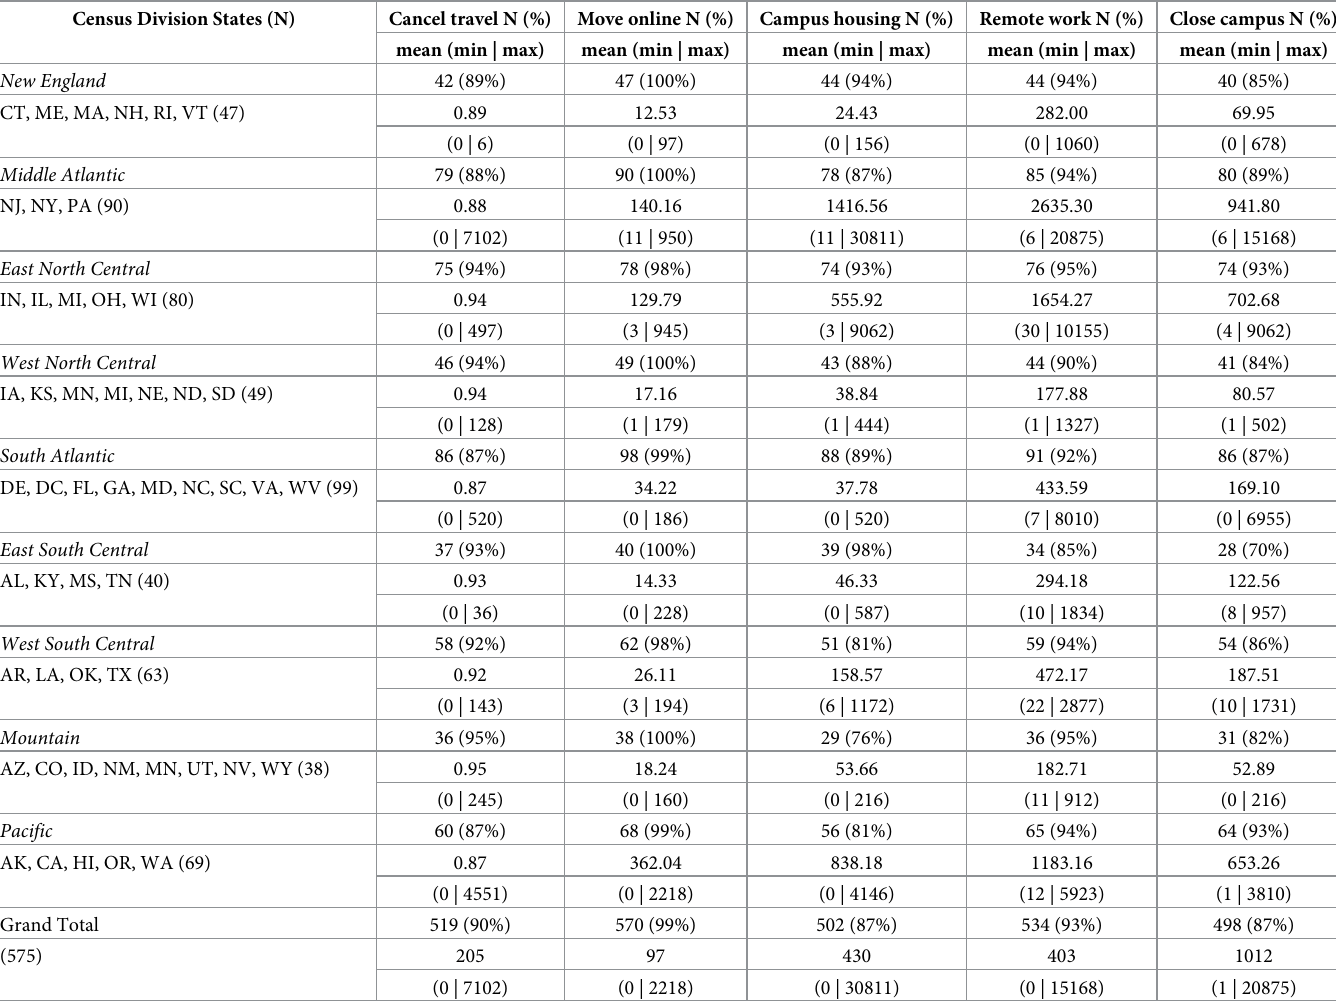
Table 1. Descriptive statistics mean positive cases and ranges for each Census Division and NPI. Census Division States